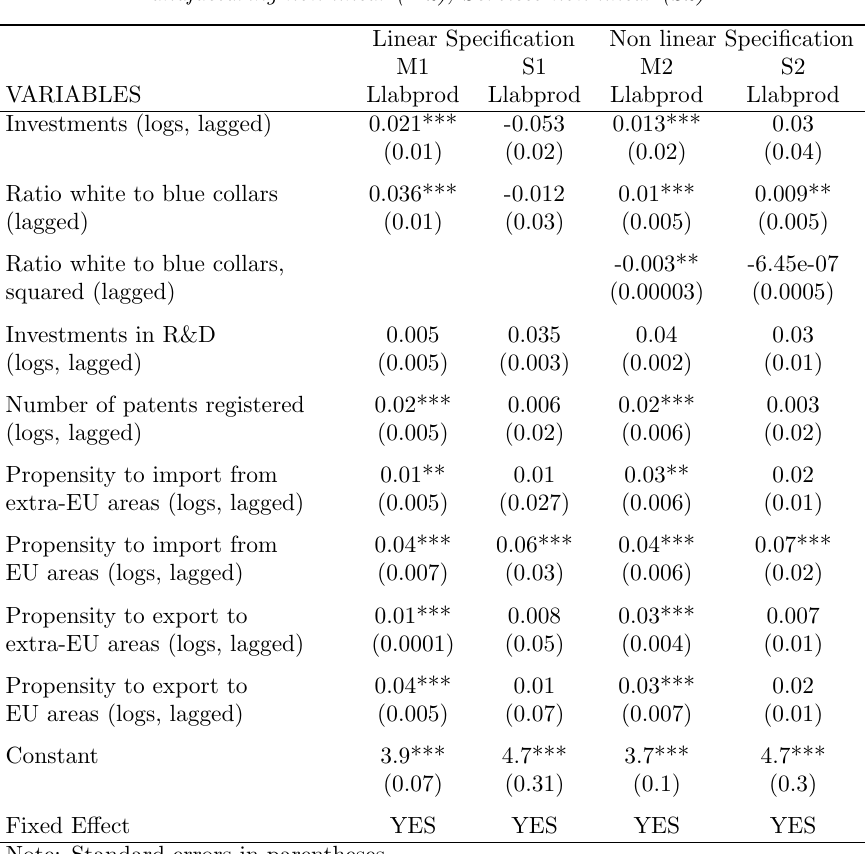
Different Specifications’ GLS Estimates: Manufacturing (M1), Services (S1), Manufacturing non linear (M2), Services non linear